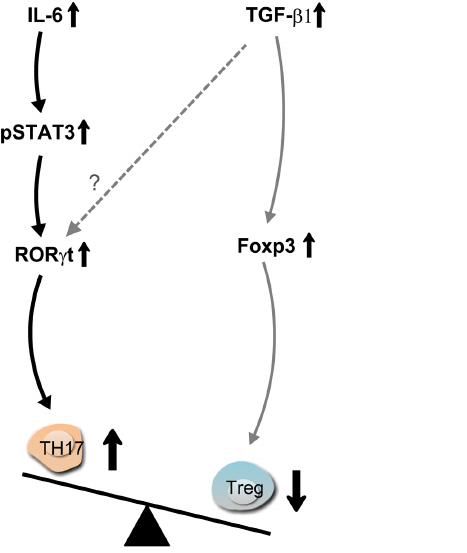
Figure 5. Schematic representation of the pathways regulating the frequencies of Th17/Treg cell populations in ACS. IL-6- activated STAT3 signaling upregulates ROR c t to promote Th17 cell differentiation through naı¨ve T cells. High levels of TGF- b 1 in ACS patients promote Treg cells differentiation but may inhibit Th17 cell differentiation. Imbalanced Th17 and Treg cell frequencies in ACS patients may originate from the reciprocal modulations by IL-6 and TGF- b